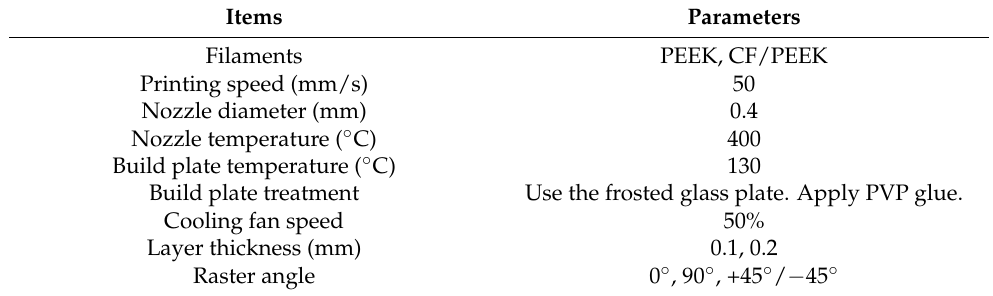
Table 2. Parameters for FDM